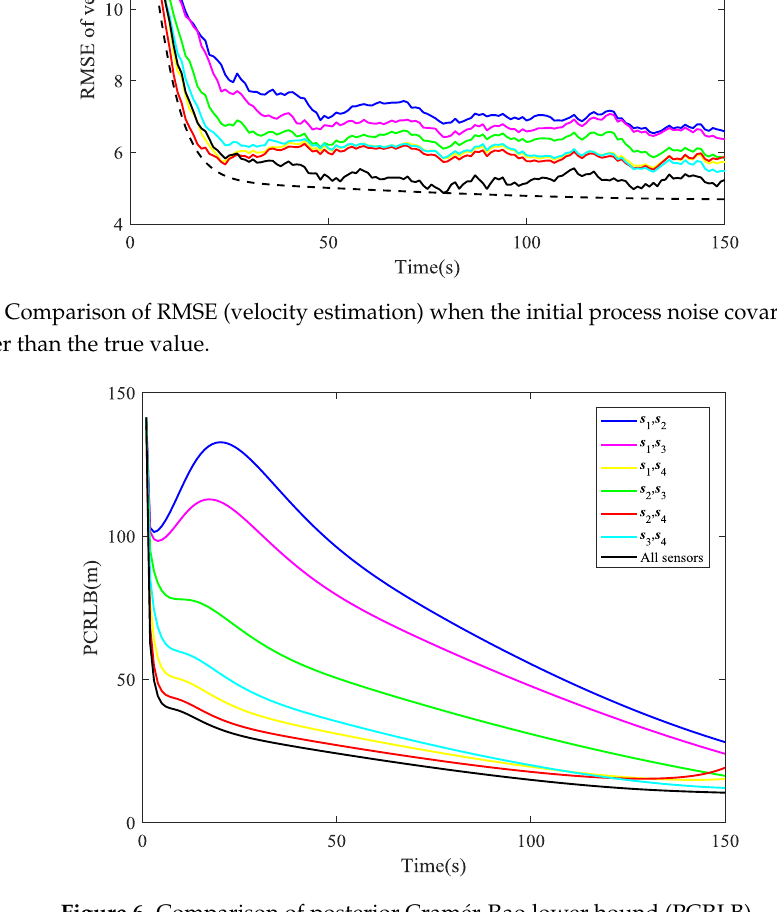
Figure 6. Comparison of posterior Cramér-Rao lower bound (PCRLB).